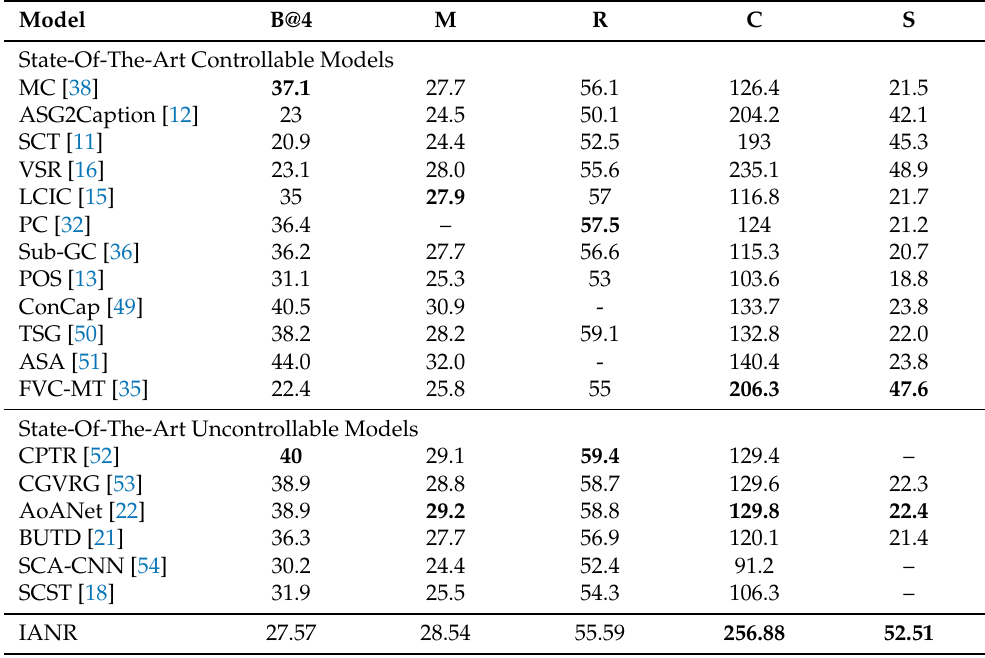
Table 3. Comparisons with the state-of-the-art on the MSCOCO Entities dataset. B@4, M, R, C, and S stand for BLUE@4, METEOR, ROUGE-L, CIDEr, and SPICE, respectively. Bold for the best.